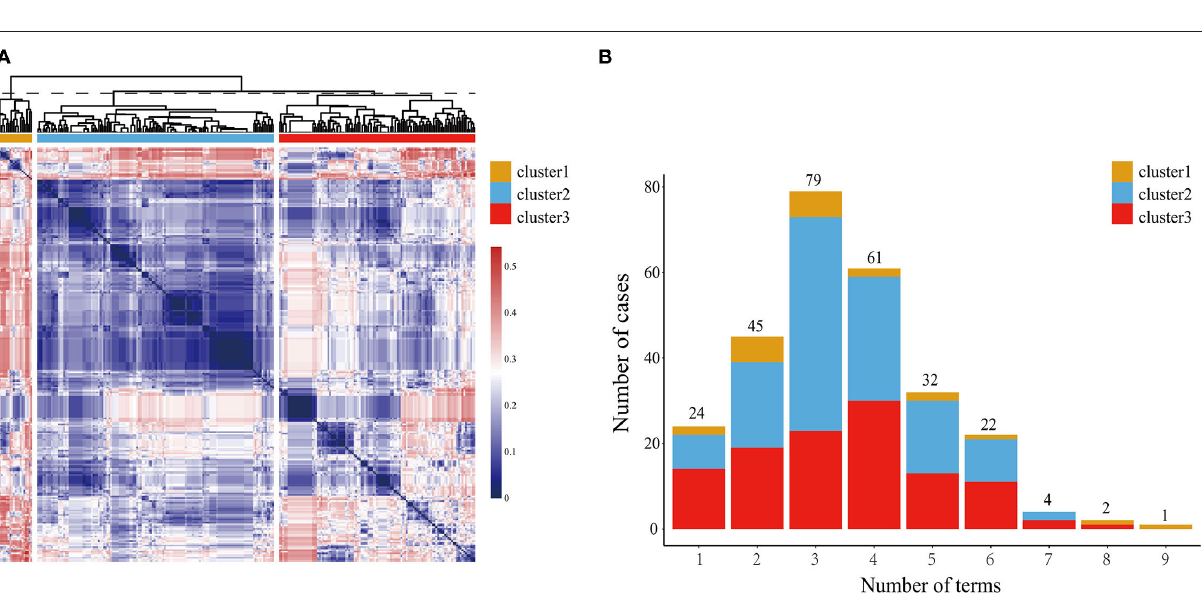
FIGURE 2 | Characteristics of three phenotypic clusters. (A) Heatmap of clustering for patients with ccTGA. The phenotypic similarity was calculated to generate the distance matrix, which was further used to produce the heatmap. Both horizontal and vertical axis indicated patients with ccTGA. The dashed line showed the height to cut the tree into three groups. The color represents the degree of similarity between patients (lighter color indicates higher similarity, with the color key on the right) yellow, blue, and red were adopted to distinguish three different clusters (yellow for cluster 1, blue for cluster 2, and red for cluster 3); (B) Number of phenotypes of patients in each cluster. ccTGA, congenitally corrected transposition of the great